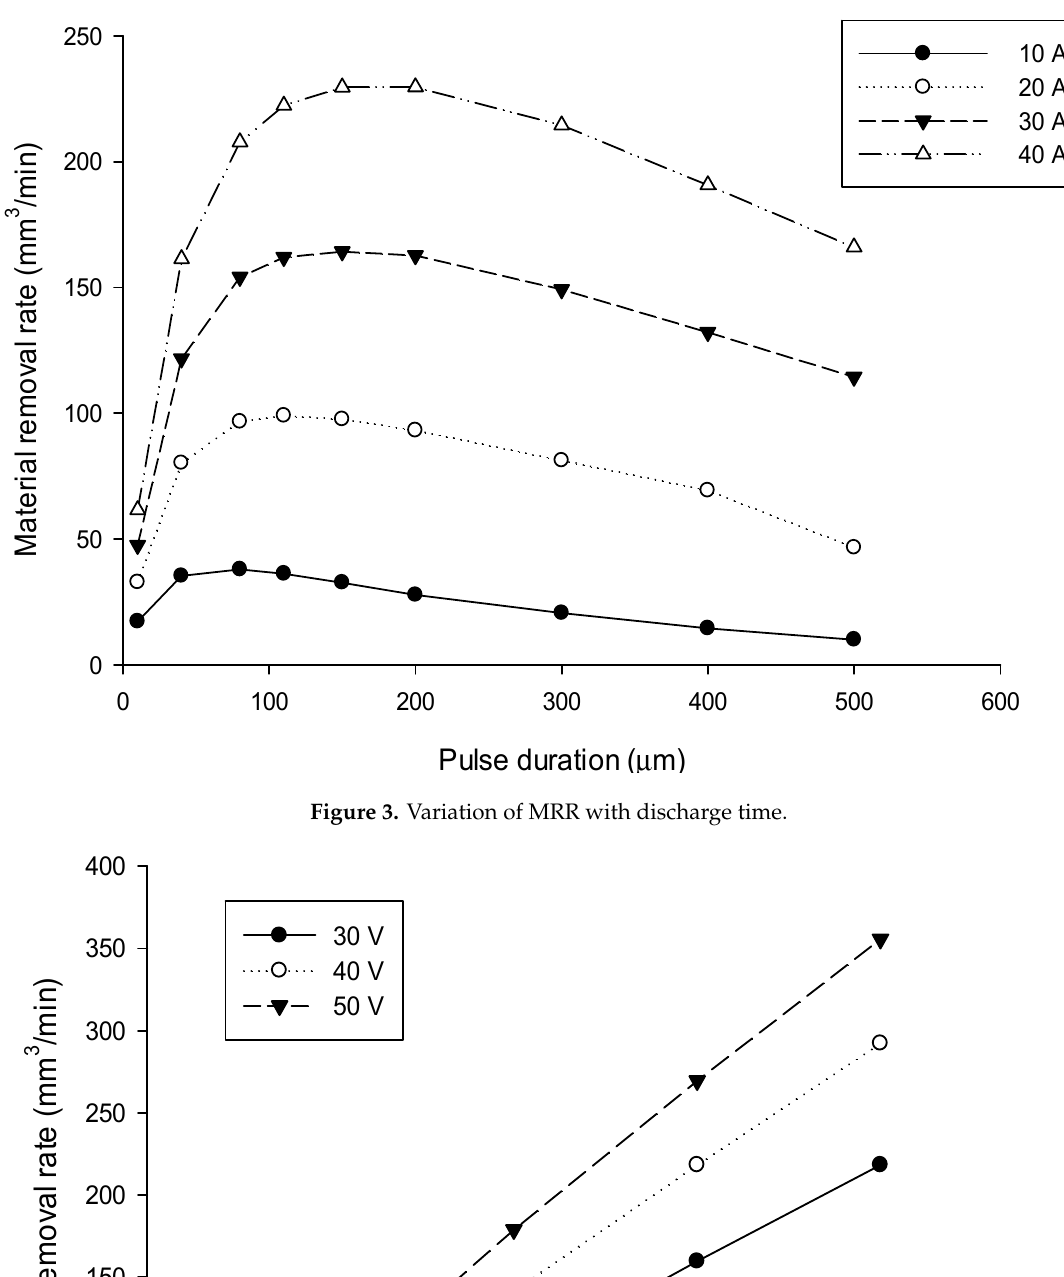
Figure 4. Effects of discharge current and voltage on MRR. Figure 4. E ff ects of discharge current and voltage on